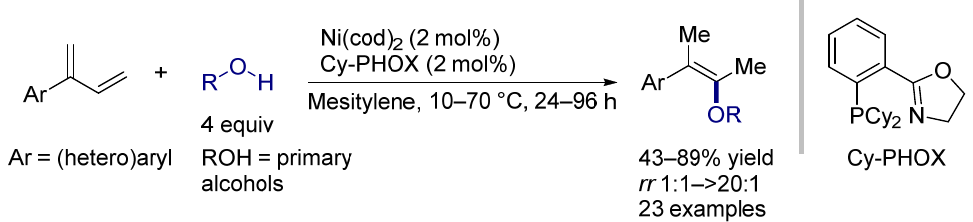
Figure 17. Regioselective Ni-catalyzed hydroalkoxylation of 2-(hetero)aryl-substituted 1,3-dienes and primary alcohols. rr = regioselectivity defined as ratio 3,4-addition product vs. 1,4-addition products.